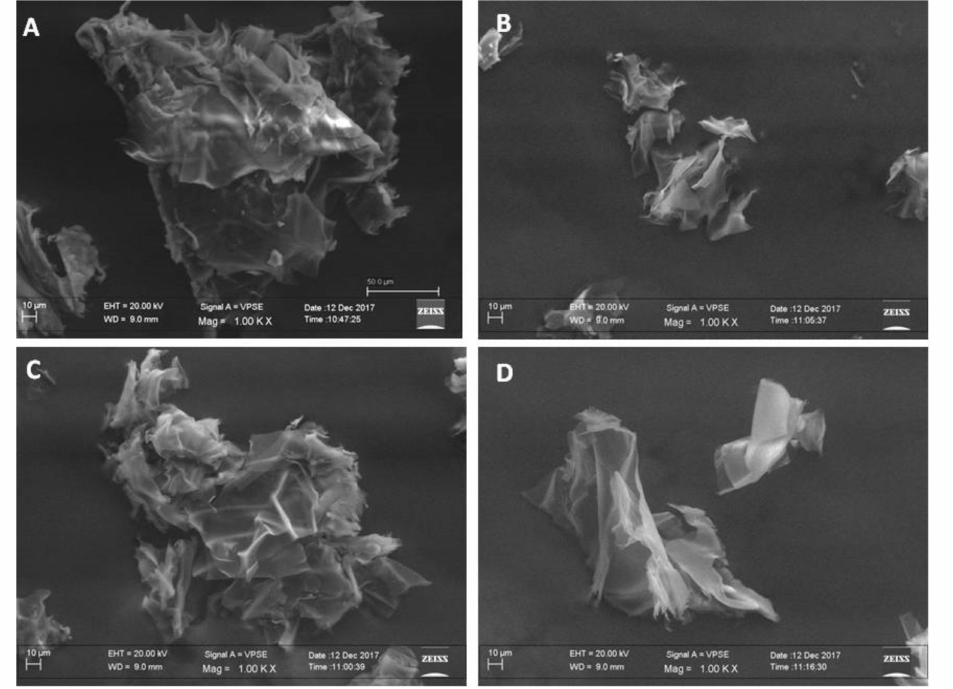
Figure 1. SEM morphological surface analysis of fragments from CS ( A ), GNp ( B ), GN1p ( C ) and GN2p ( D ) powders, 500 ×